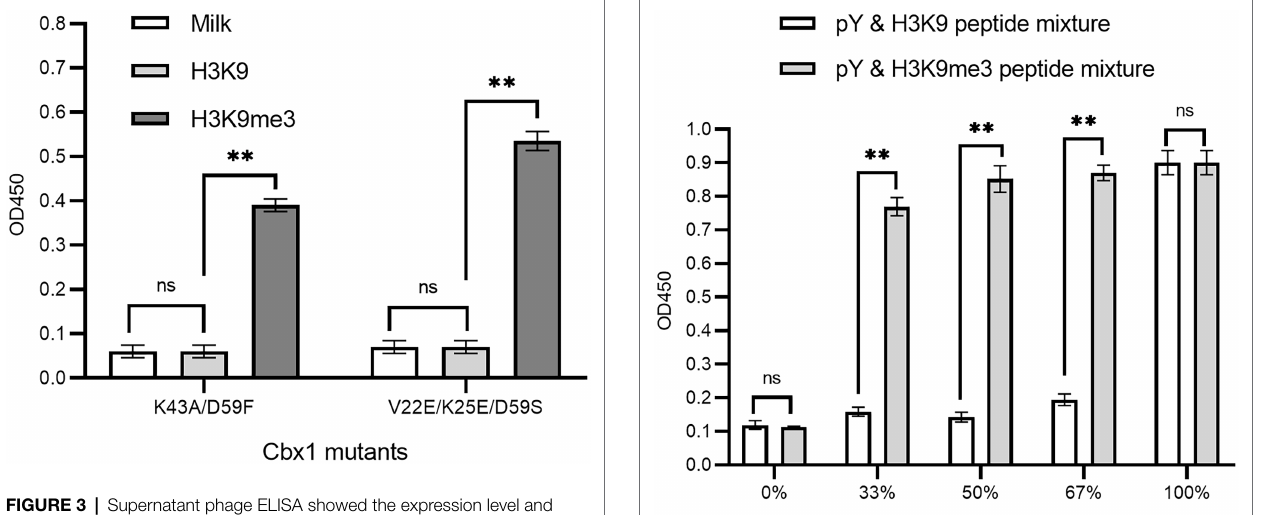
FIGURE 3 | Supernatant phage ELISA showed the expression level and binding to the H3K9me3 peptide of the Cbx1 mutants. The milk and the H3K9 peptide were considered background and the negative control, respectively. The experiments were repeated three times. The experiments were repeated three times. FIGURE 4 | Supernatant ELISA signals were plotted as a function of the